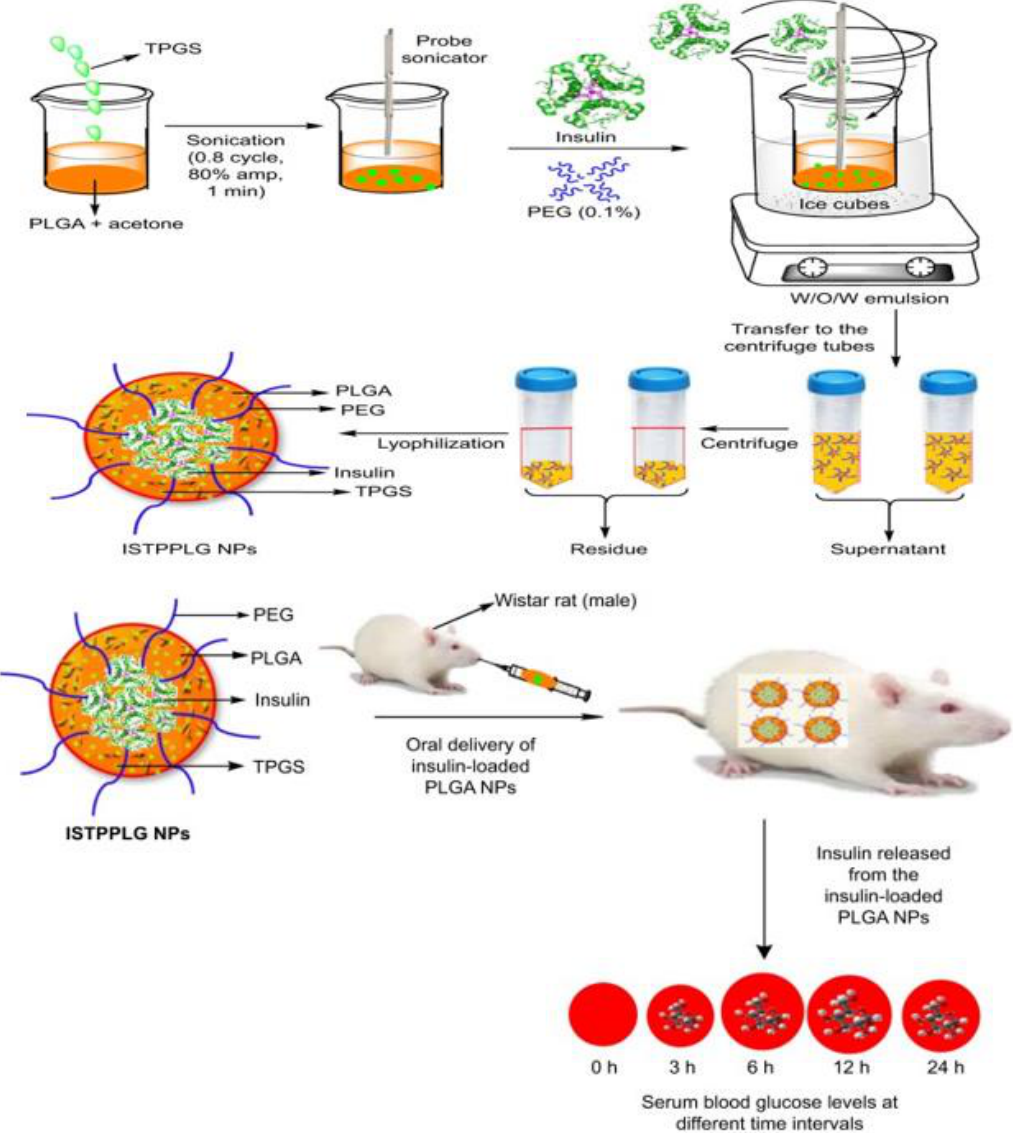
Figure 5. TPGS-emulsified PEG-capped PLGA nanoparticles loaded with insulin are synthesized using TPGS-emulsified PEG-capped PEG, and insulin release from PEG-capped TPGS-emulsified PLGA nanoparticles containing insulin-loaded TPGS-emulsified TPGS nanoparticles [79].